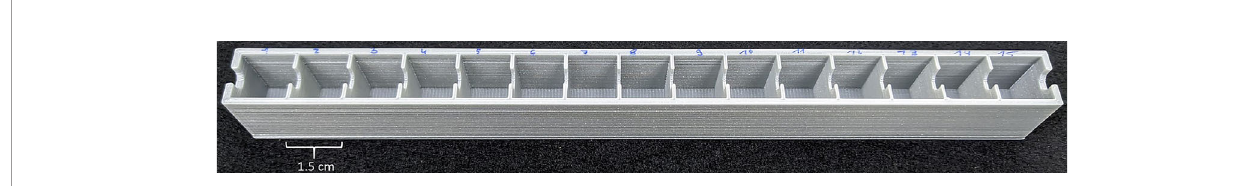
FIGURE 1 | Custom made 3D printed device to measure phosphate uptake and root exudation of single cluster root tissue types with a temporal and spatial